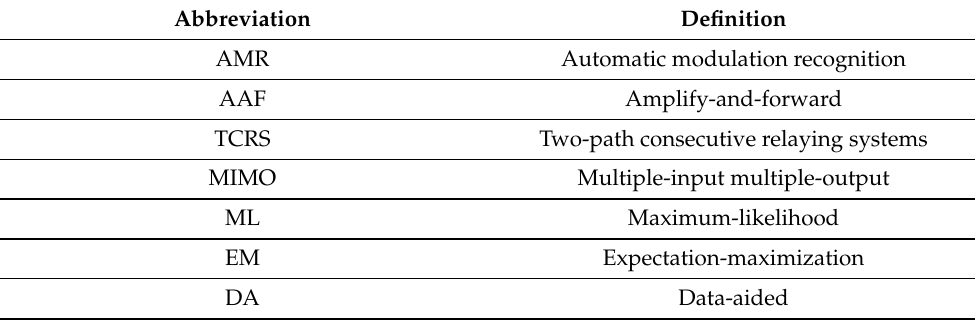
Table 1. List of